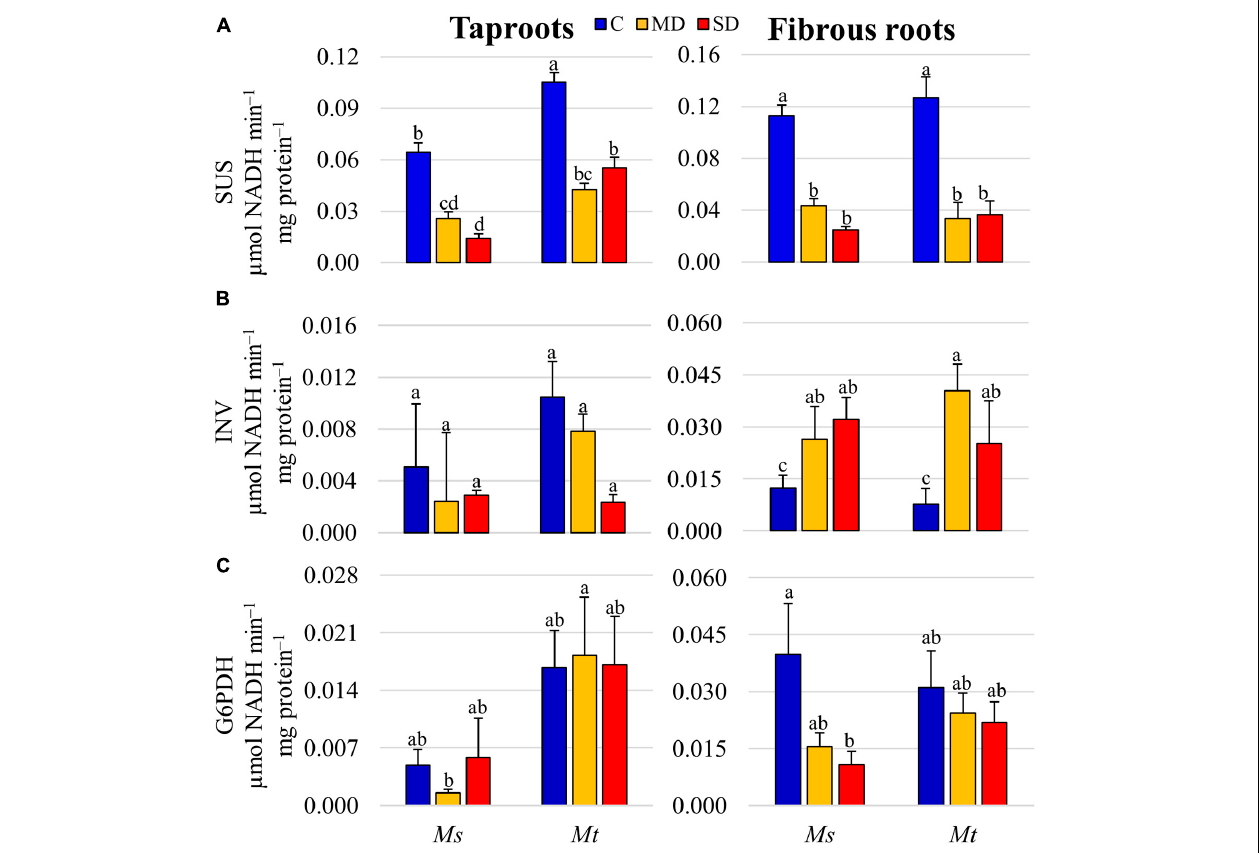
FIGURE 6 | Enzymatic activities of key carbon metabolism proteins in different root tissues. (A) Levels of sucrose synthase (SUS), (B) alkaline invertase (INV), and (C) glucose 6-phosphate dehydrogenase (G6PDH) specific activities. Bars represent means ± SEs ( n = 4 biological replicates). Different letters indicate significant differences according to a Duncan-test ( P ≤ 0.05). C, control; MD, moderate water deficit; SD, severe water deficit; fibRs, fibrous roots; tapRs, taproots; Ms, Medicago sativa; Mt, M. truncatula